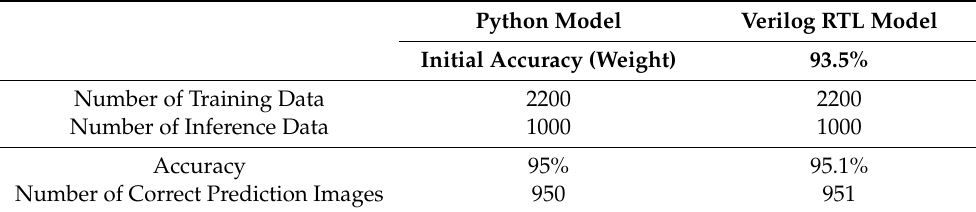
Table 2. Comparison of Python and RTL test accuracy for training and inference.